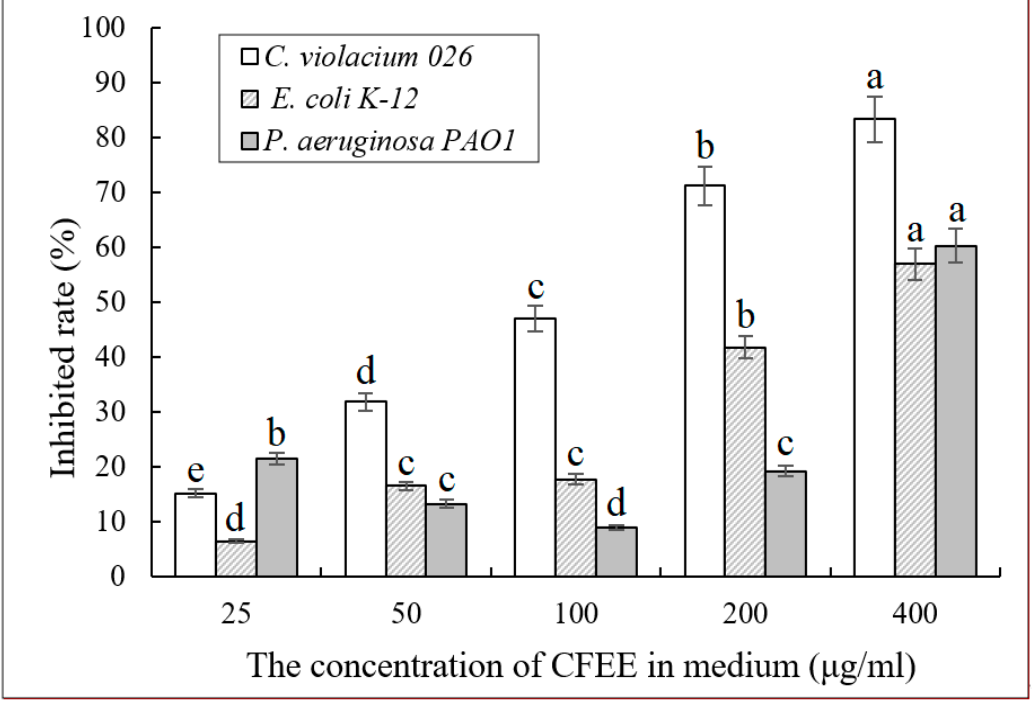
Figure 4. Inhibited rate of bacteria biofilm formation of tested strains under different concentrations of CFEE. Each bar represents the average of five measurements and their standard deviations. Different letters indicate significant differences in inhibition rates.